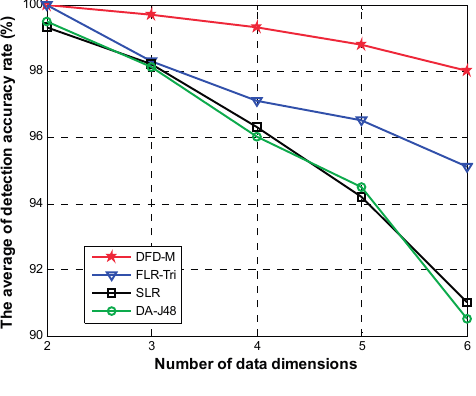
Figure 12. Detection accuracy rate.